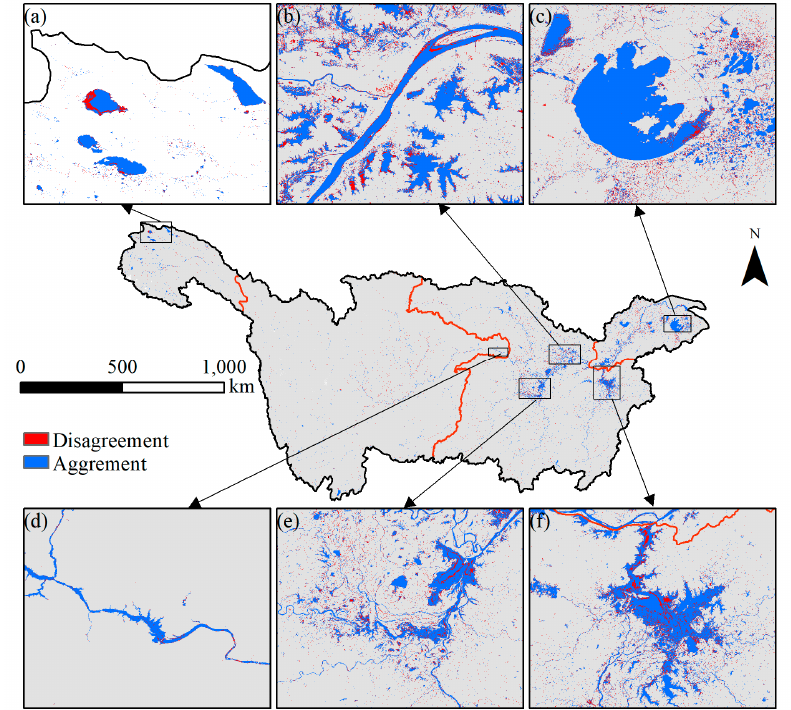
Figure 17. Comparisons of the spatial pattern of permanent and seasonal water bodies of this study and JRC water product. “Agreement” indicated both the water mapping have the same water type. In contrast, “Disagreement” indicated the two water mapping having di ff erent water types. ( a – f ) indicates the source regions of the YRB, Wuhan city, Taihu Lake, the Three Gorges Dam (TGD), Dongting Lake and Poyang Lake,